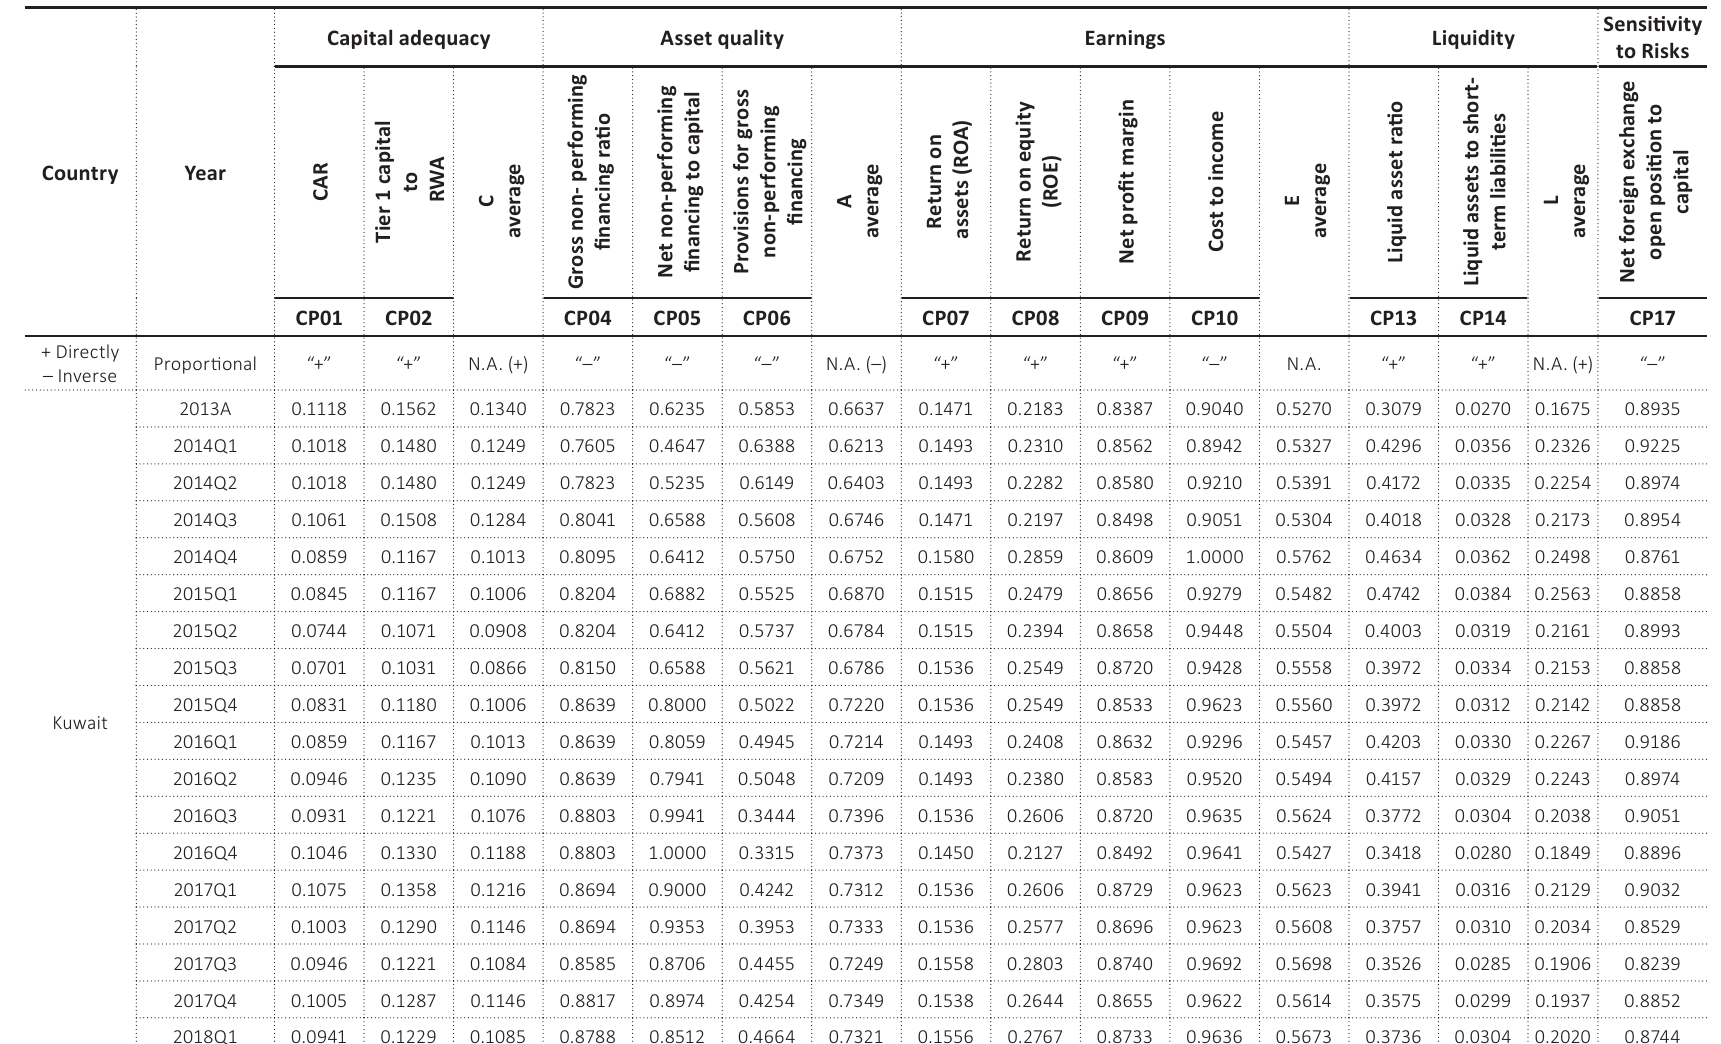
Source: Own calculation based on IFSB database.